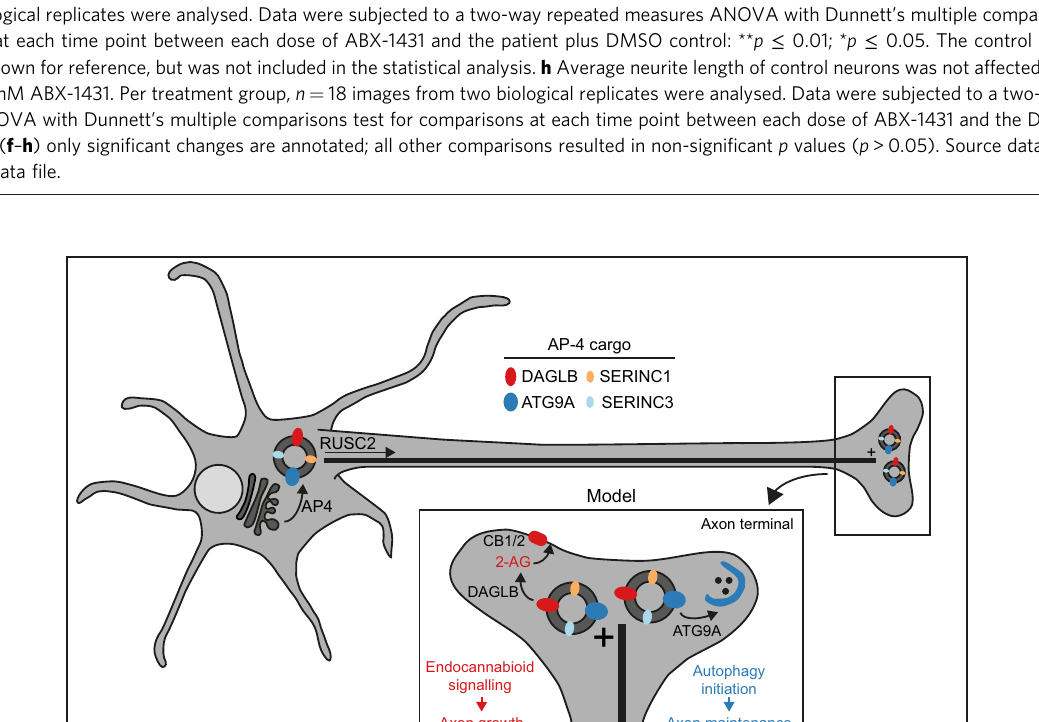
Fig. 8 A new cellular disease model for AP-4 de fi ciency syndrome. Proposed model for the role of AP-4 in axonal transport based on our new and published data. AP-4 acts at the trans-Golgi network (TGN) membrane to package its cargo proteins, DAGLB, ATG9A, SERINC1 and SERINC3, into transport vesicles. RUSC2 mediates microtubule plus-end-directed transport of AP-4-derived vesicles, delivering cargo to the distal axon. DAGLB is an enzyme responsible for production of the endocannabinoid 2-AG, known to be required for axonal growth via autocrine activation of cannabinoid receptors. The previous model for AP-4 de fi ciency syndrome has focused on missorting of ATG9A, which is required for autophagy initiation and hence for axonal maintenance. We now propose that the neuronal pathology in AP-4 de fi ciency arises from the compound effects of DAGLB missorting on axonal development and ATG9A missorting on axonal